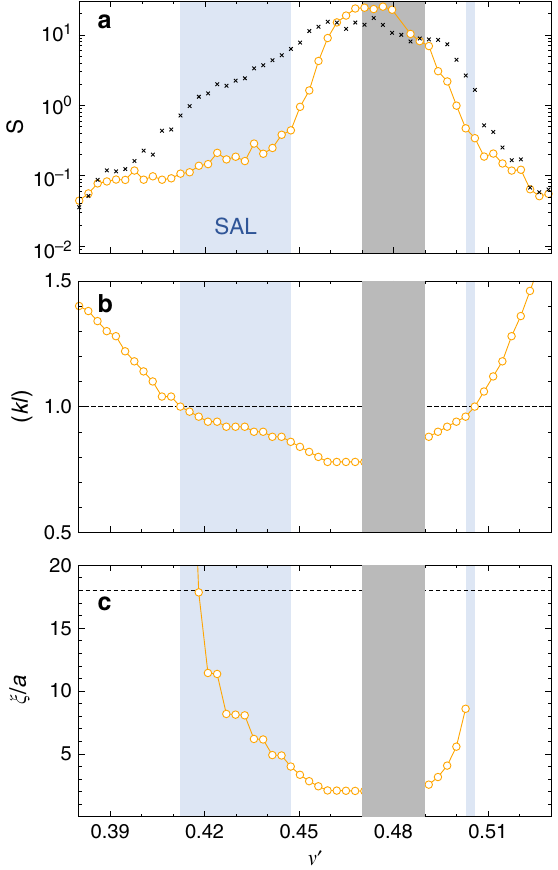
Fig. 5 Single-parameter fi t to the data using SC theory. The values obtained from the fi t are displayed as open circles. The only adjustable parameter is ( kl ). The optical mean free path ℓ is de fi ned via ð kl Þ ¼ ‘=‘ ´ ν 0 = ν 0 c c , Fig. 4. a Least square error S. Crosses: Fit to the data with diffusion theory, Eq. (1) with ~ L ¼ L . The blue shaded area indicate where the SC theory provides an accurate and better description of the numerical data indicating SAL. b Localization parameter extracted from the single-parameter fi t. c The localization length, given by ξ / a = 6( ℓ / a )( kl ) 2 / (1 − ( kl ) 4 ). The horizontal dashed line indicates the largest accessible length scale in the simulation, given by the edge length of the simulation box L = 18 a